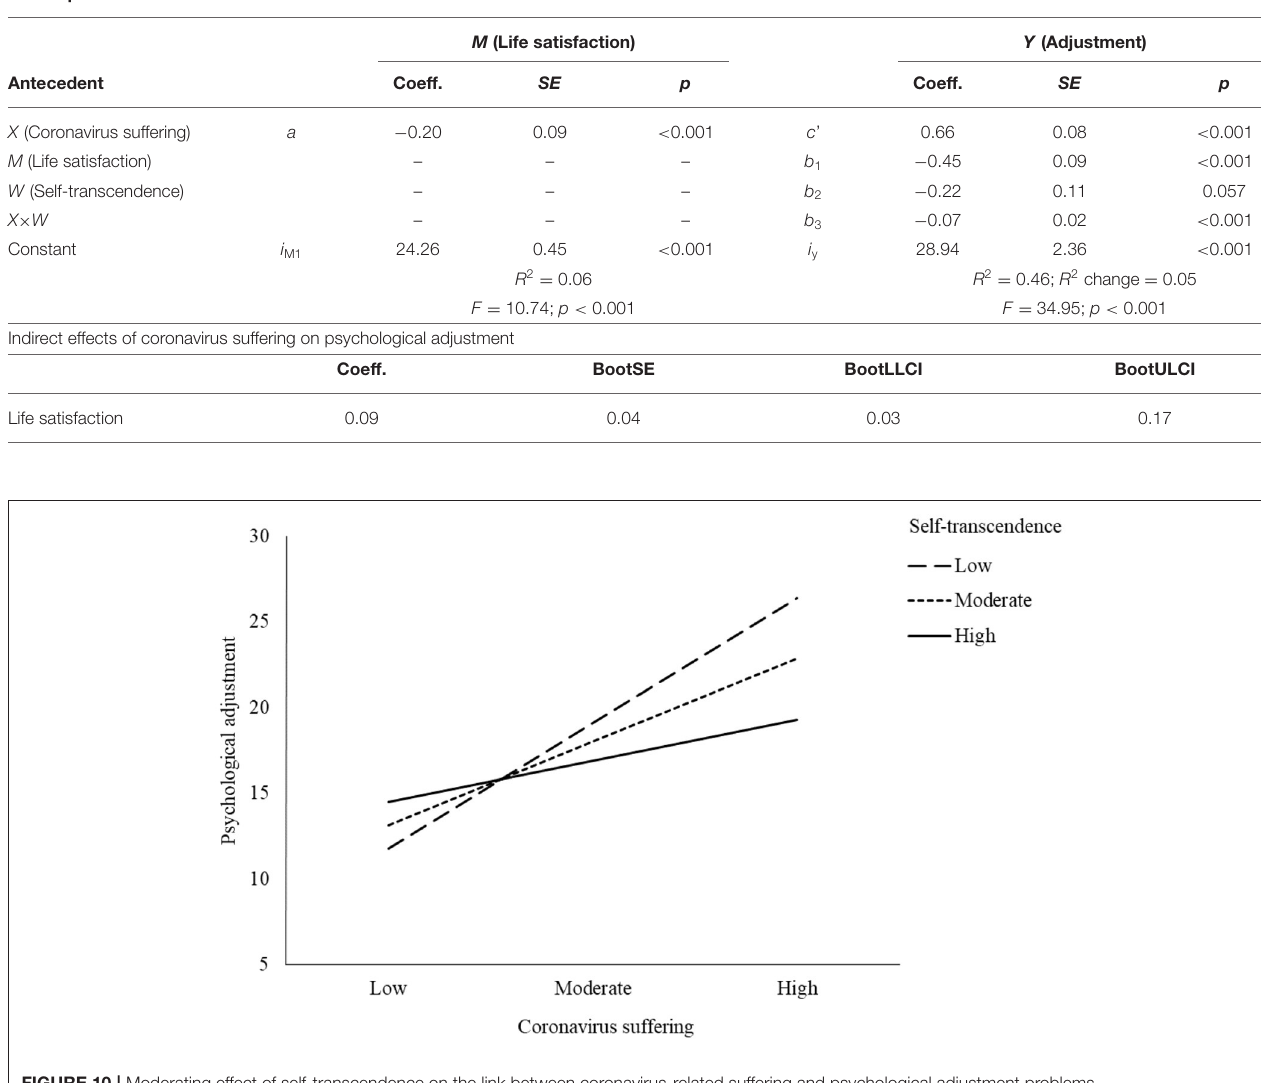
adjustment problems ( r = − 0.47, p < 0.001), as seen